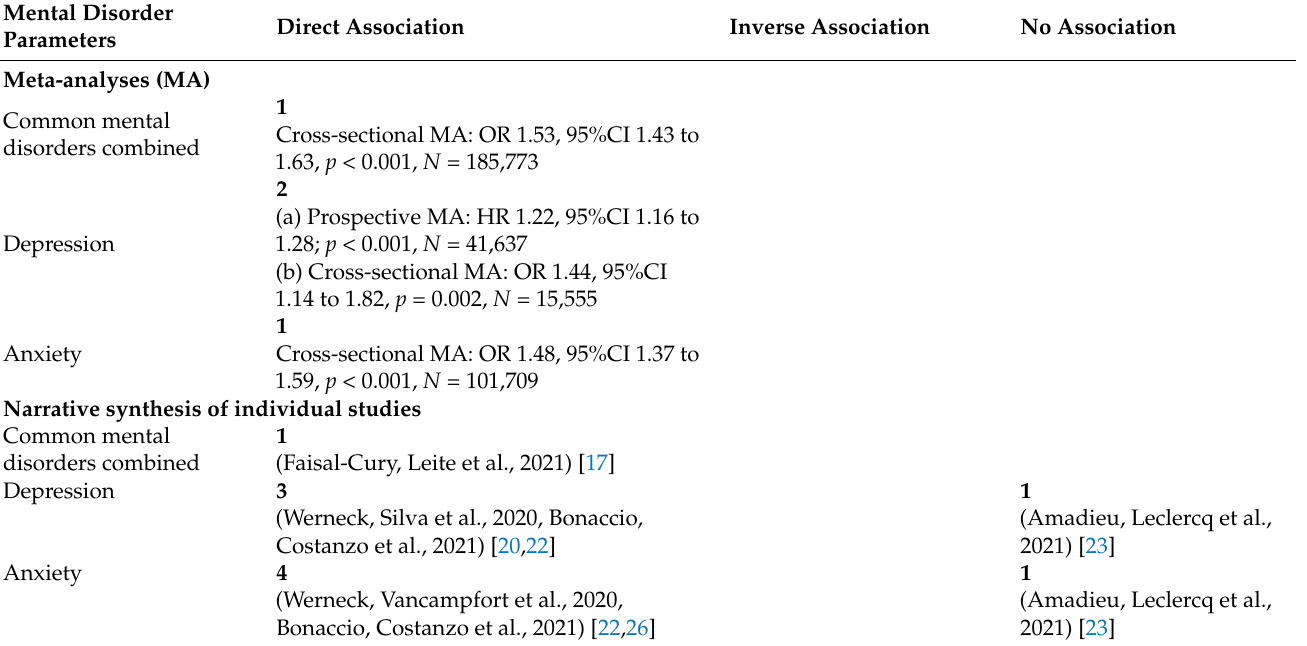
Table 2. Number and direction of associations from our meta-analyses (top part of table) and from studies included only in the narrative syntheses (bottom part of